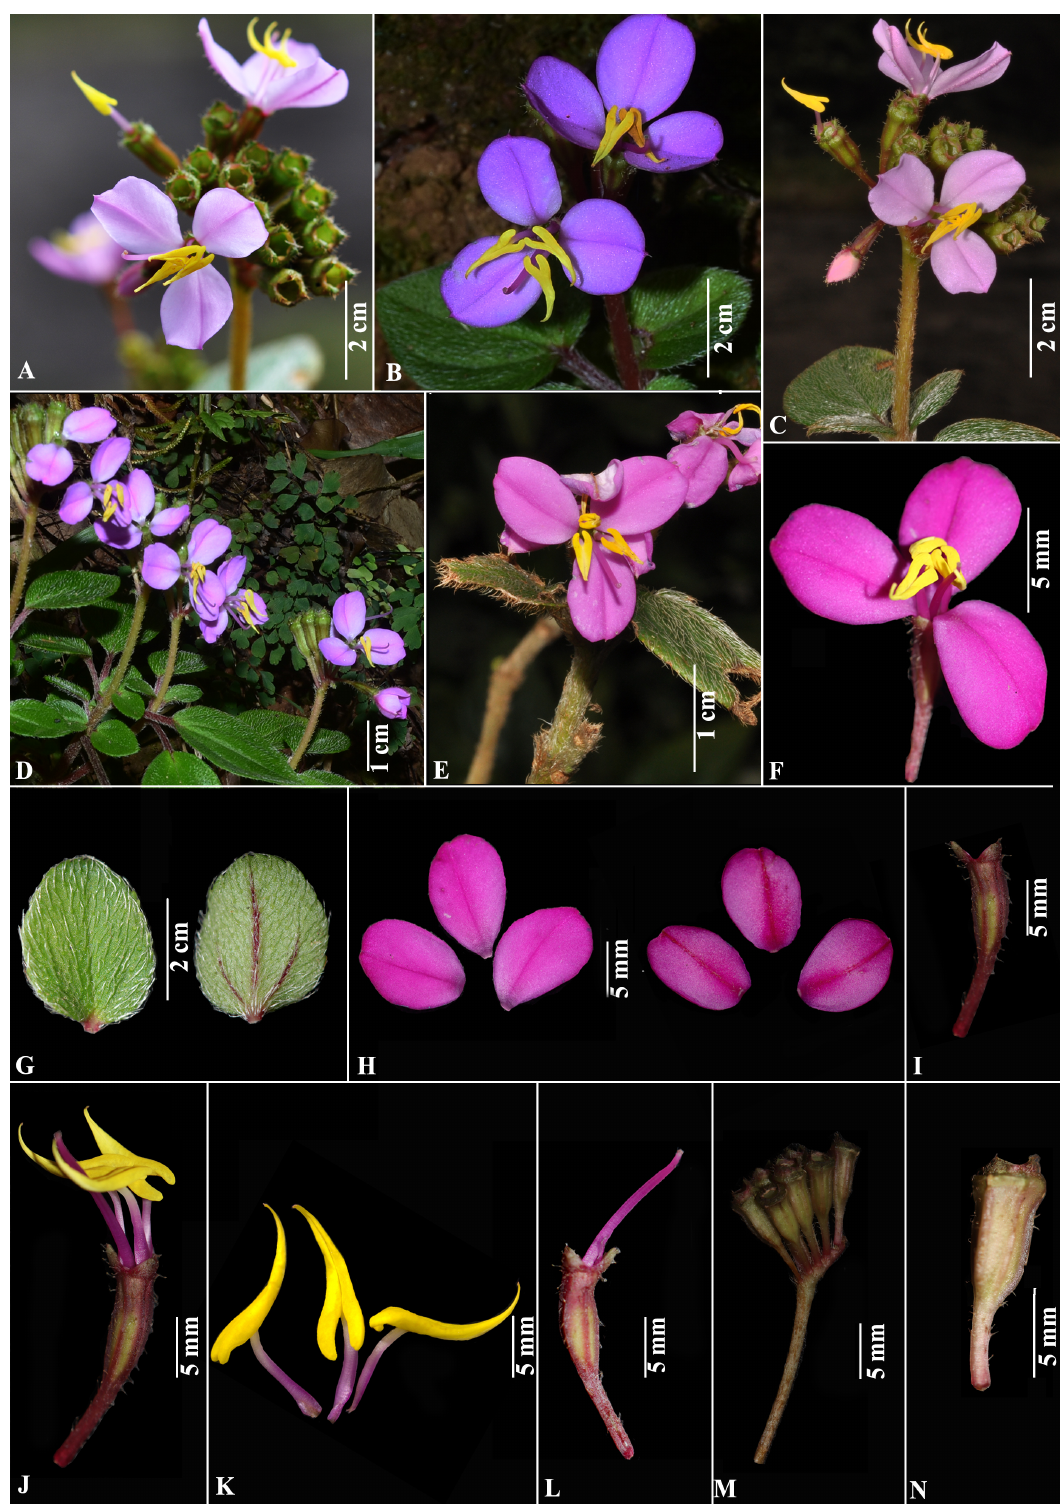
Fig. 6. Sonerila travancorica Bedd . A – D . Inflorescences showing flowers with emarginated and mucronate petals. E – F . Flowers. G . Lamina with dense long white hairs. H . Petals, adaxial and abaxial views. I . Hypanthium. J . Hypanthium with stamens and pistil. K . Stamens. L . Pistil M . Immature capsules. N . Mature capsule. Photographs: A, C, E by Prashob P.; B, D, F–N by Resmi